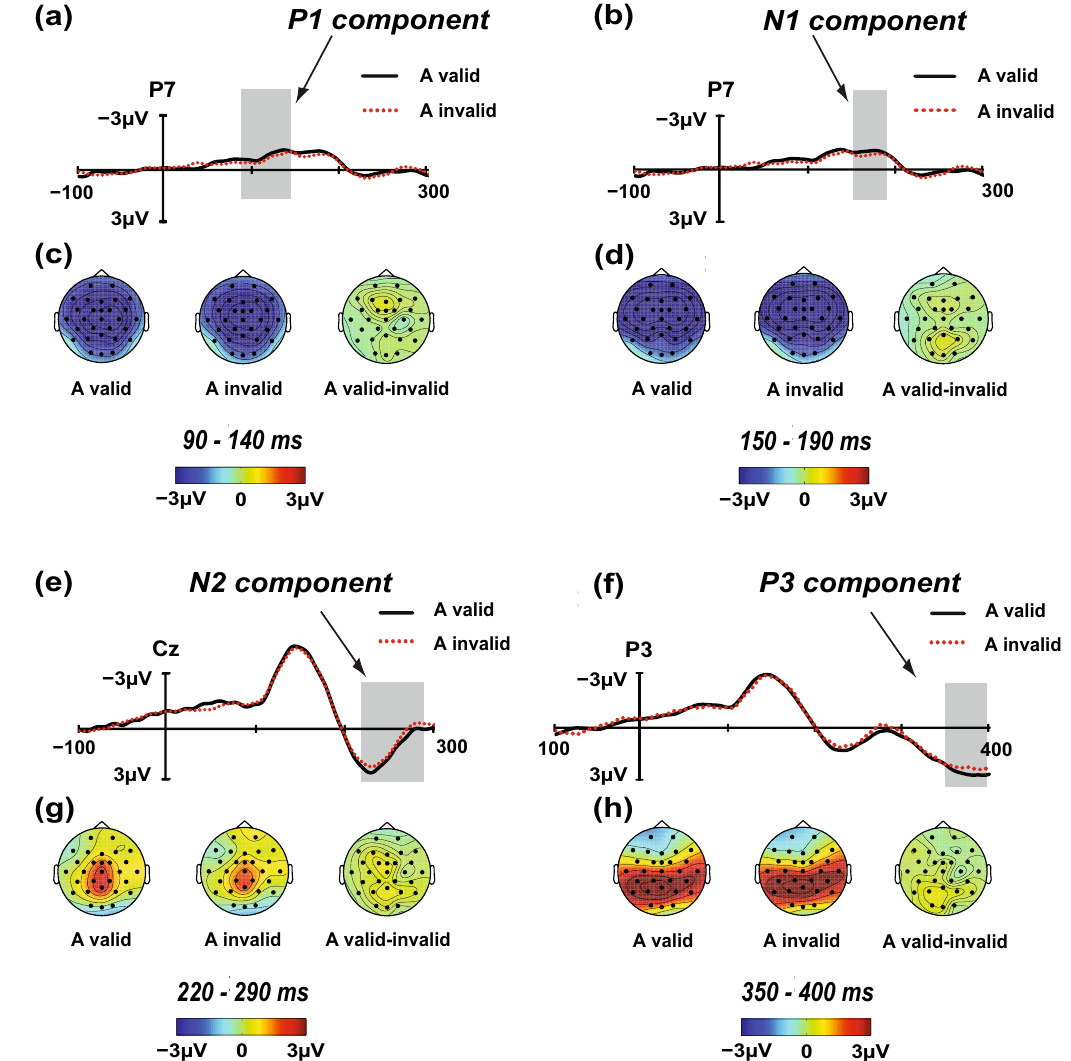
Figure 2. Direct comparisons of the auditory IOR effect for the time windows 90–140 ms, 150–190 ms, 220– 290 ms, and 350–400 ms. The contrasts between the valid and invalid locations were analysed using t test (sig. two-tailed; 95% confidence interval, CI), and the maximum difference between the valid and invalid locations is shown from P7 electrode, P7 electrode, Cz electrode and P3 electrode, for the P1, N1, N2 and P3 components, respectively. The grand average amplitudes elicited by the A targets presented in either the valid (black solid) or invalid (red dotted) locations are shown in panels ( a ), ( b ), ( e ), and ( f ). The scalp topographies of the P1, N1, N2 and P3 components in the valid and invalid waveforms are shown in panels ( c ), ( d ), ( g ), and ( h ), respectively. Valid-invalid scalp topographies represent the IOR